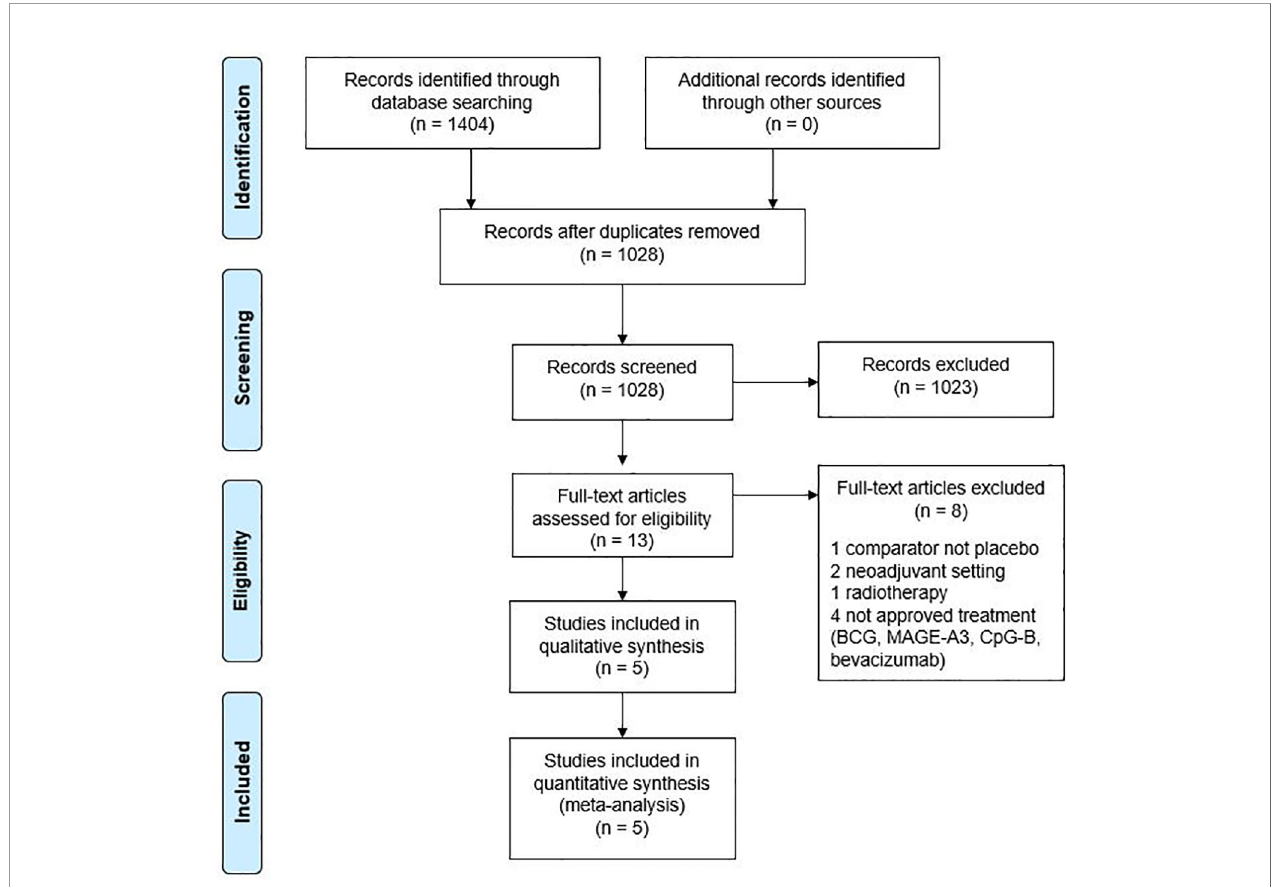
FIGURE 1 | Meta-analysis fl owchart. BCG, bacillus Calmette-Guerin; MAGE-A3, melanoma antigen